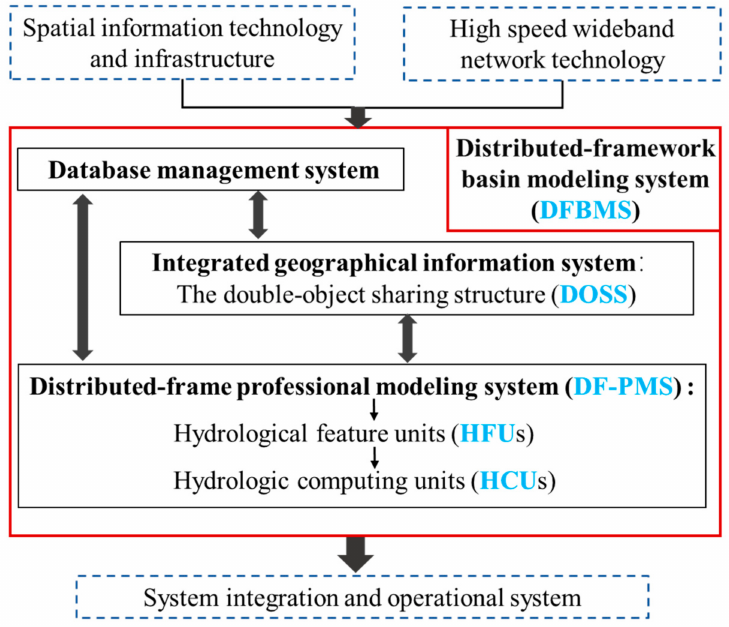
Figure 1. The structure of the distributed-framework basin modeling system